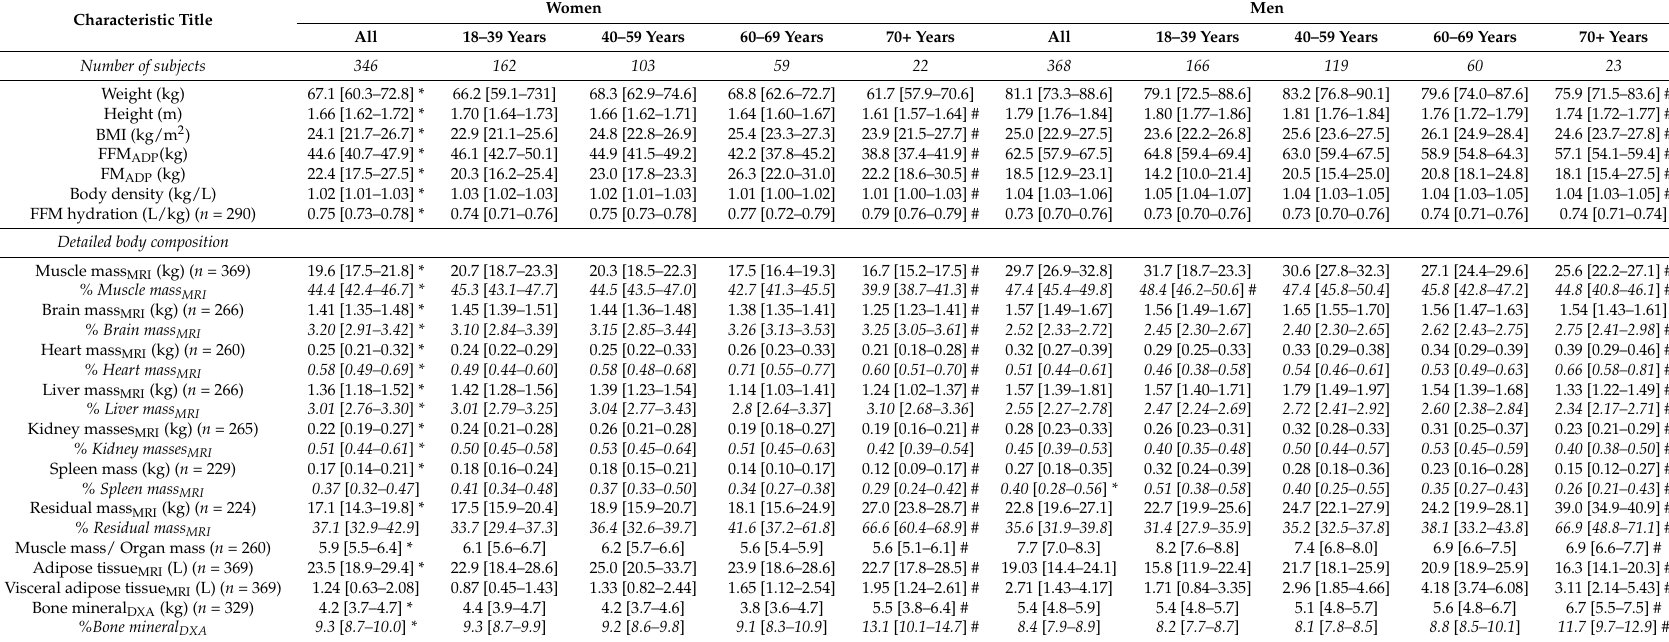
Table 1. Physical characteristics of the main study population ( n = 714) and subgroup with detailed body composition ( n =